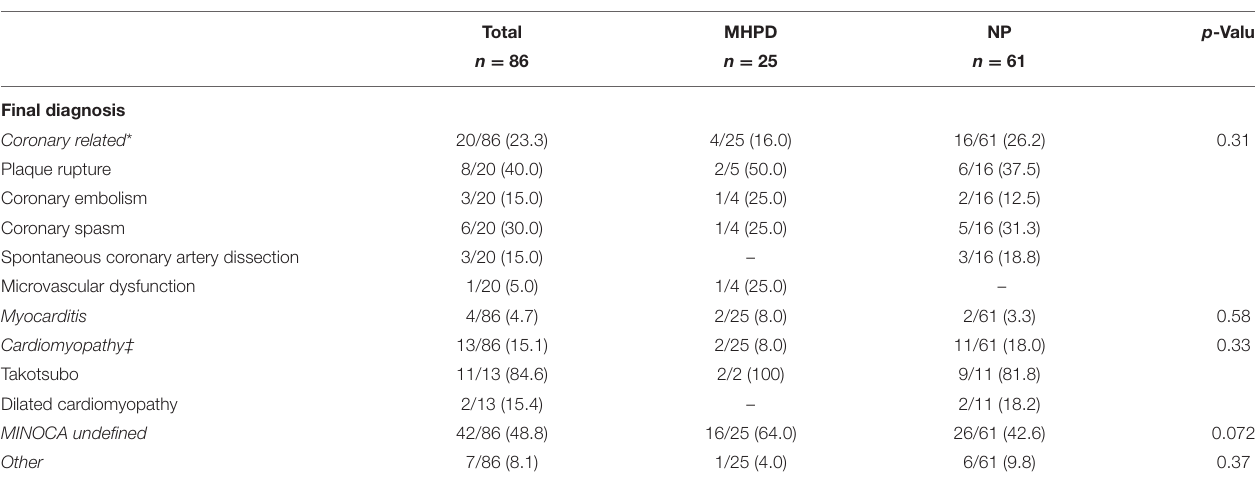
TABLE 4 | Final diagnosis of